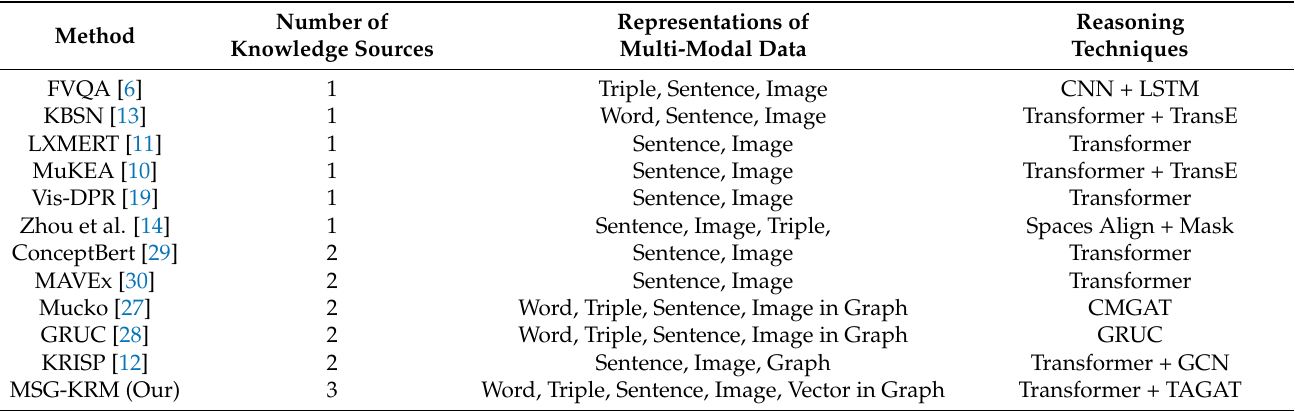
Table 1. Comparison of some methods in